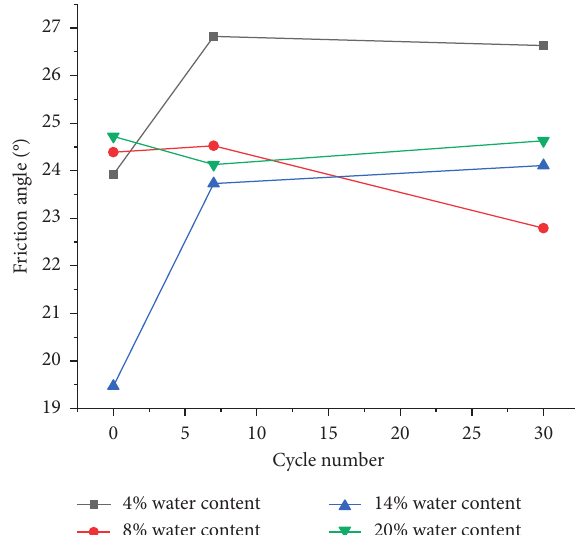
Figure 15: The friction angle-cycle number curve with different water